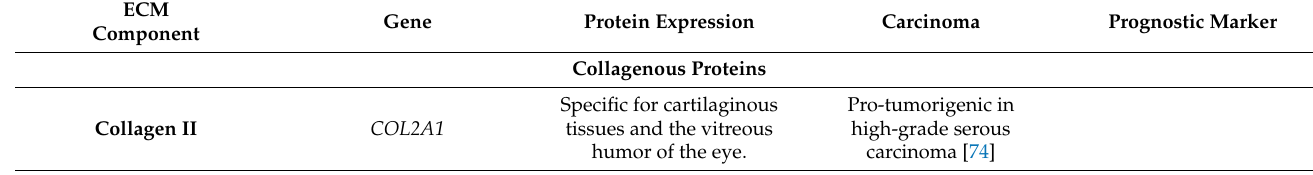
Table 1. Expression of bone- and cartilage-specific matrix proteins in epithelial